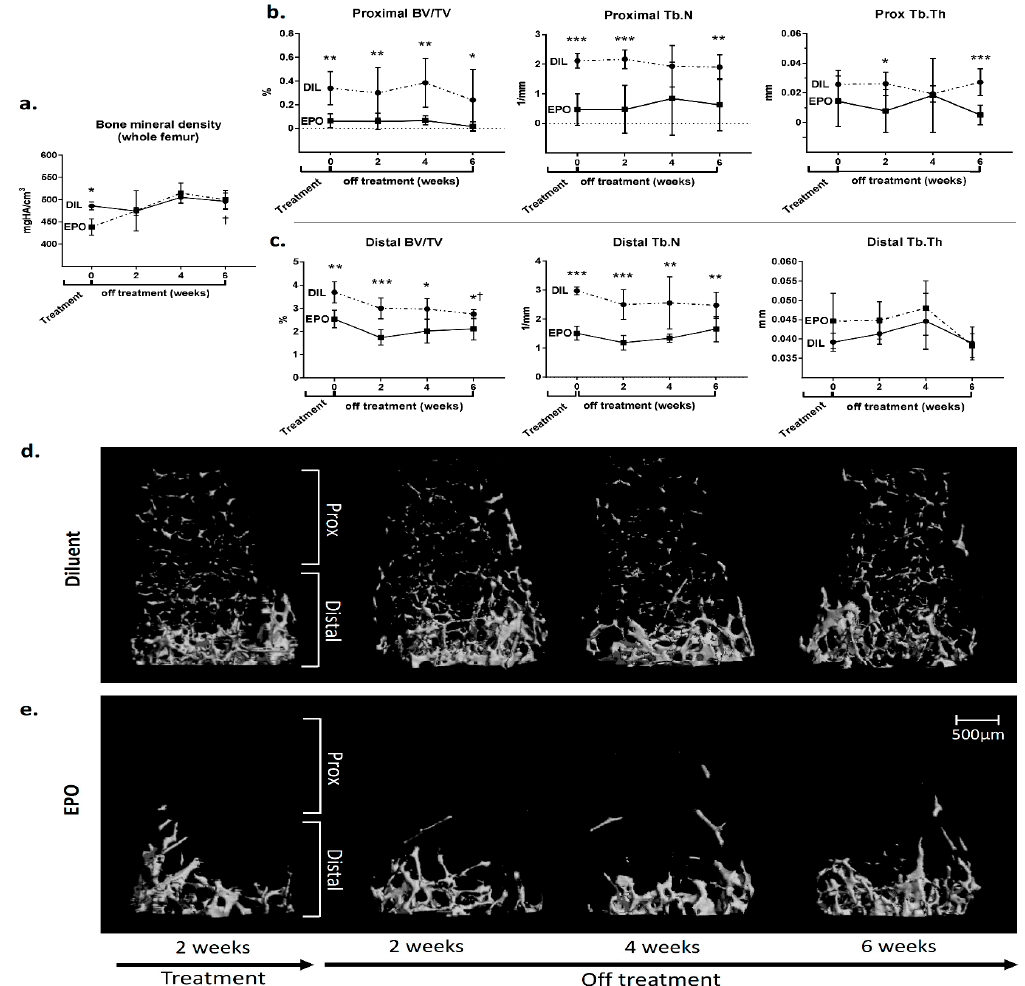
Figure 4. EPO induces irreversible changes in the microarchitecture of the trabecular bone of the femur. ( a ) Volumetric bone mineral density (vBMD) of the whole femur of female mice treated with either diluent or EPO (540 IU / week) at the end of the treatment period and 2, 4 and 6 weeks post treatment. ( b , c ) Trabecular bone volume (BV / TV), trabecular number (Tb.N) and trabecular thickness (Tb.Th) of the proximal ( b ) and distal ( c ) portions of the femoral metaphysis of mice described in ( a ). Values are mean ± SD. EPO—erythropoietin, DIL—diluent. *** p < 0.001; ** p < 0.01; * p < 0.05; † p < 0.05 relative to the “end of treatment” time point (0 weeks); ( d , e ) Representative 3D reconstruction images of the distal femoral metaphysis (subdivided into proximal and distal subregions) of mice treated with either diluent ( d ) or EPO (540 IU / week) ( e ) at corresponding time points. n = 6 for each group. An irreversible loss of the trabecular bone was also noted in the spine of the experimental animals (Figure 5). At the end of the treatment period, there was a significant 15% and 17% reduction in the “edge” and “middle” BV / TV of the L3 vertebrae, respectively (Figure